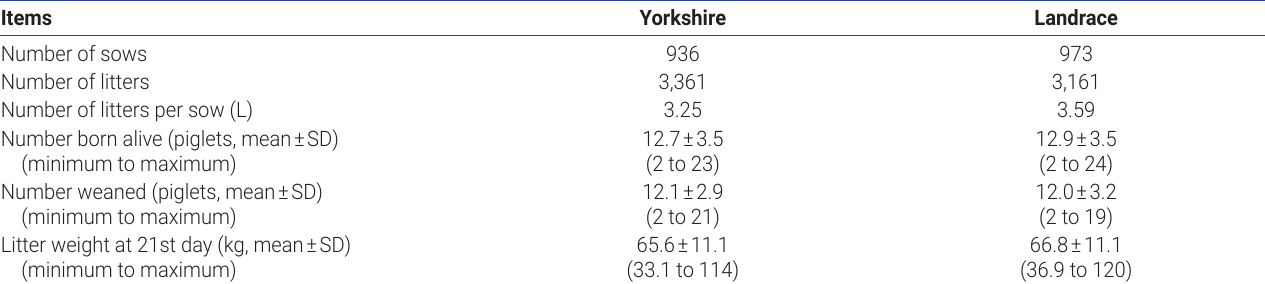
Table 2. Phenotypic parameters of litter traits in Danish Yorkshire and Landrace pigs between 2014 and 2019